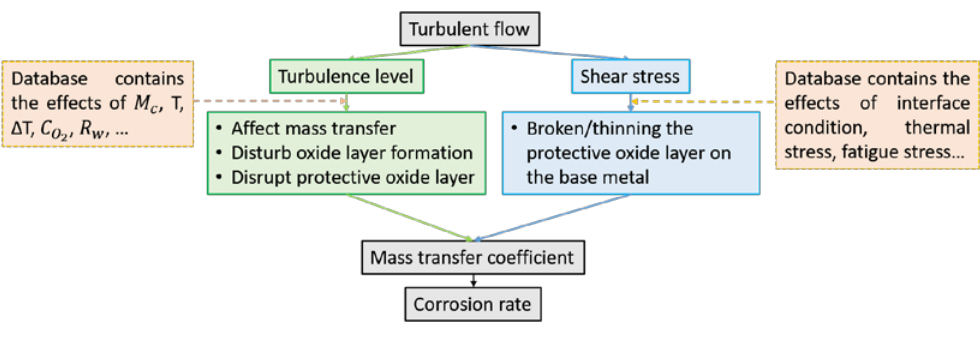
Figure 1. Schematic of the boundary layer where turbulent flow meets a no-slip wall boundary.